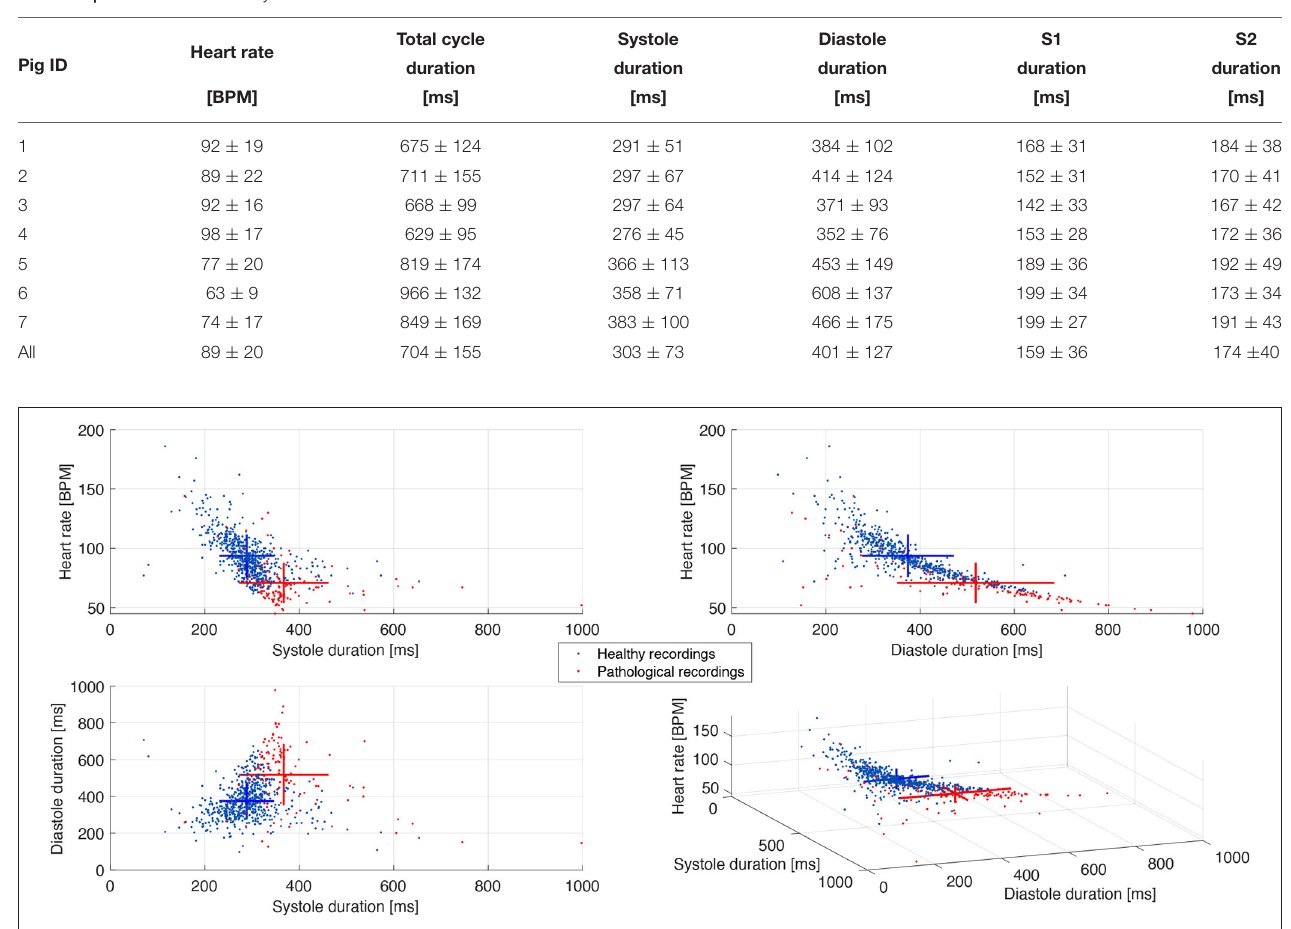
TABLE 4 | Statistics of cardiac cycle duration.